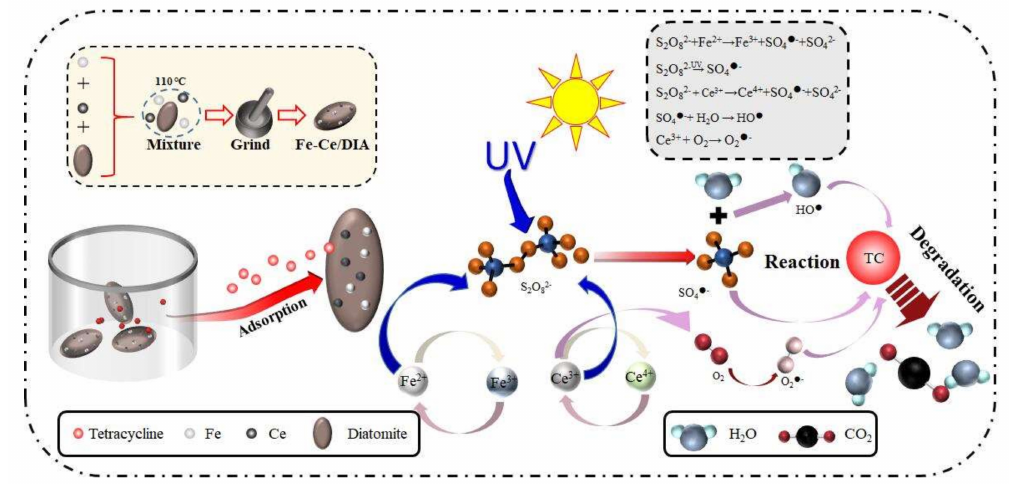
Figure 10. Potential mechanism of activation of persulfate by Fe-Ce / DIA to degrade